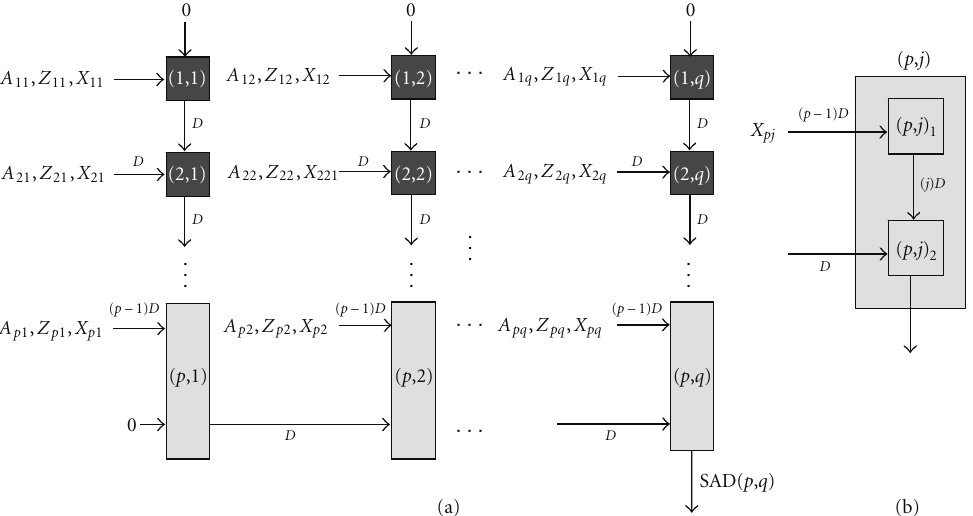
Figure 10: (a) Systolic array architecture for block computation ( p × q ). Current pixels are stored in-place and reference pixels from blocks ( X , Z , A , etc.) are fed into the array. D represents a single clock cycle delay. (b) Design of “light” PE. It is shown as two modules: ( p , j ) ( p , j ) 2